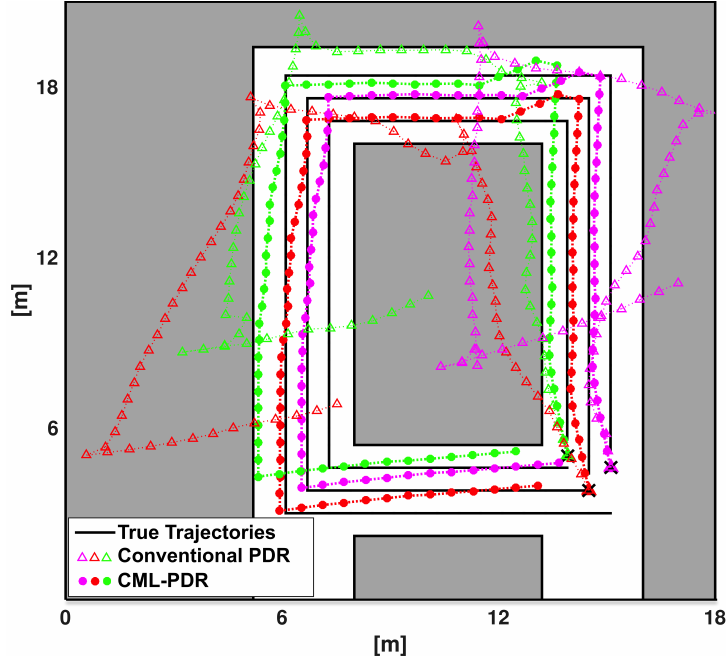
Figure 11. Localization of three users walking in different speed and over a path with several turns to verify the performance of the system for a complex scenario. Colored markers represent position estimates of the three pedestrians, while black lines indicate the true